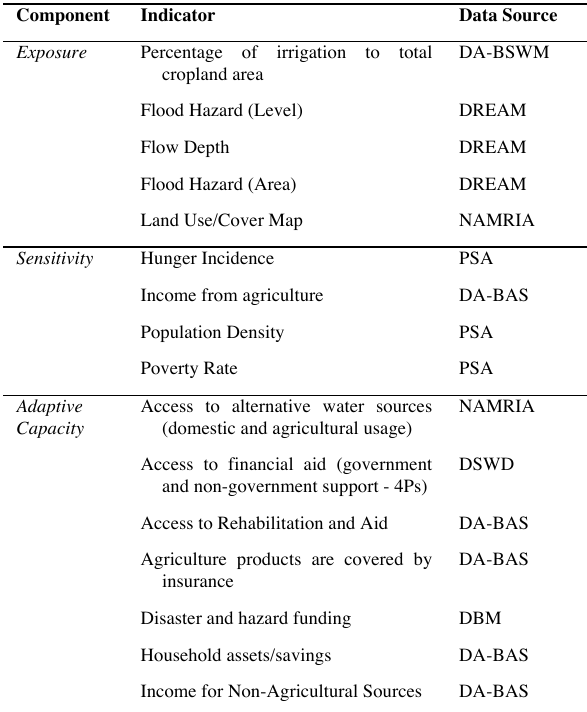
Table 1. List of indicators used in the study and the data